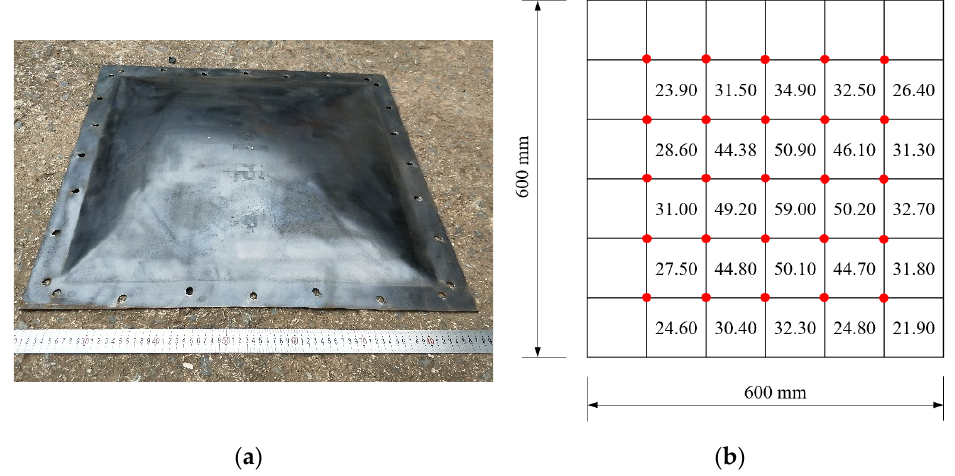
Figure 10. Deformation of the specimen with 10 g TNT. ( a ) Specimen after explosion. ( b ) Deformation details.